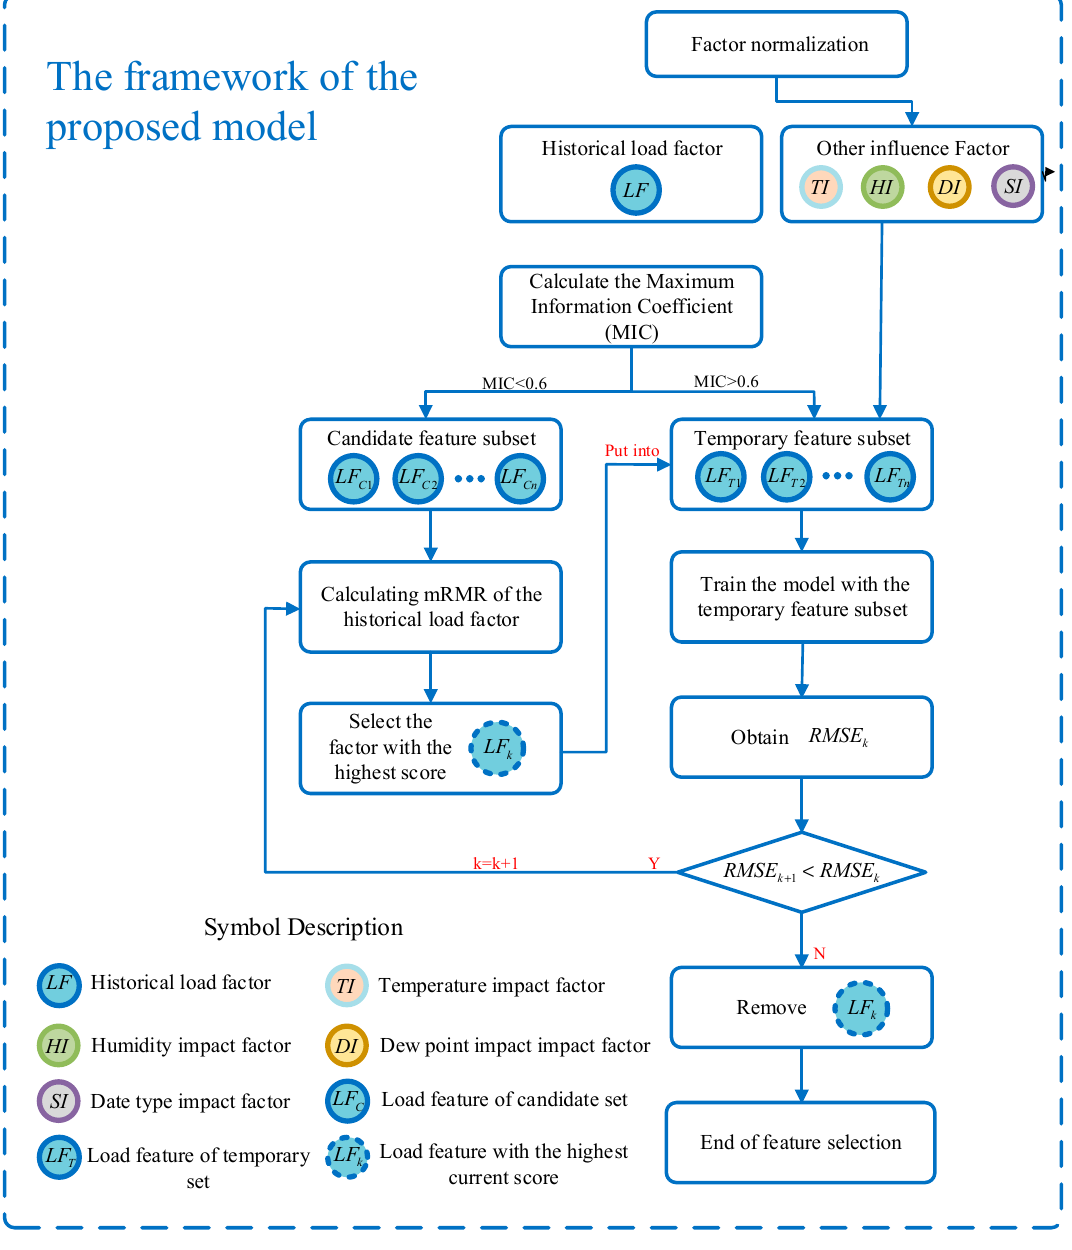
Figure 2. The framework of the proposed